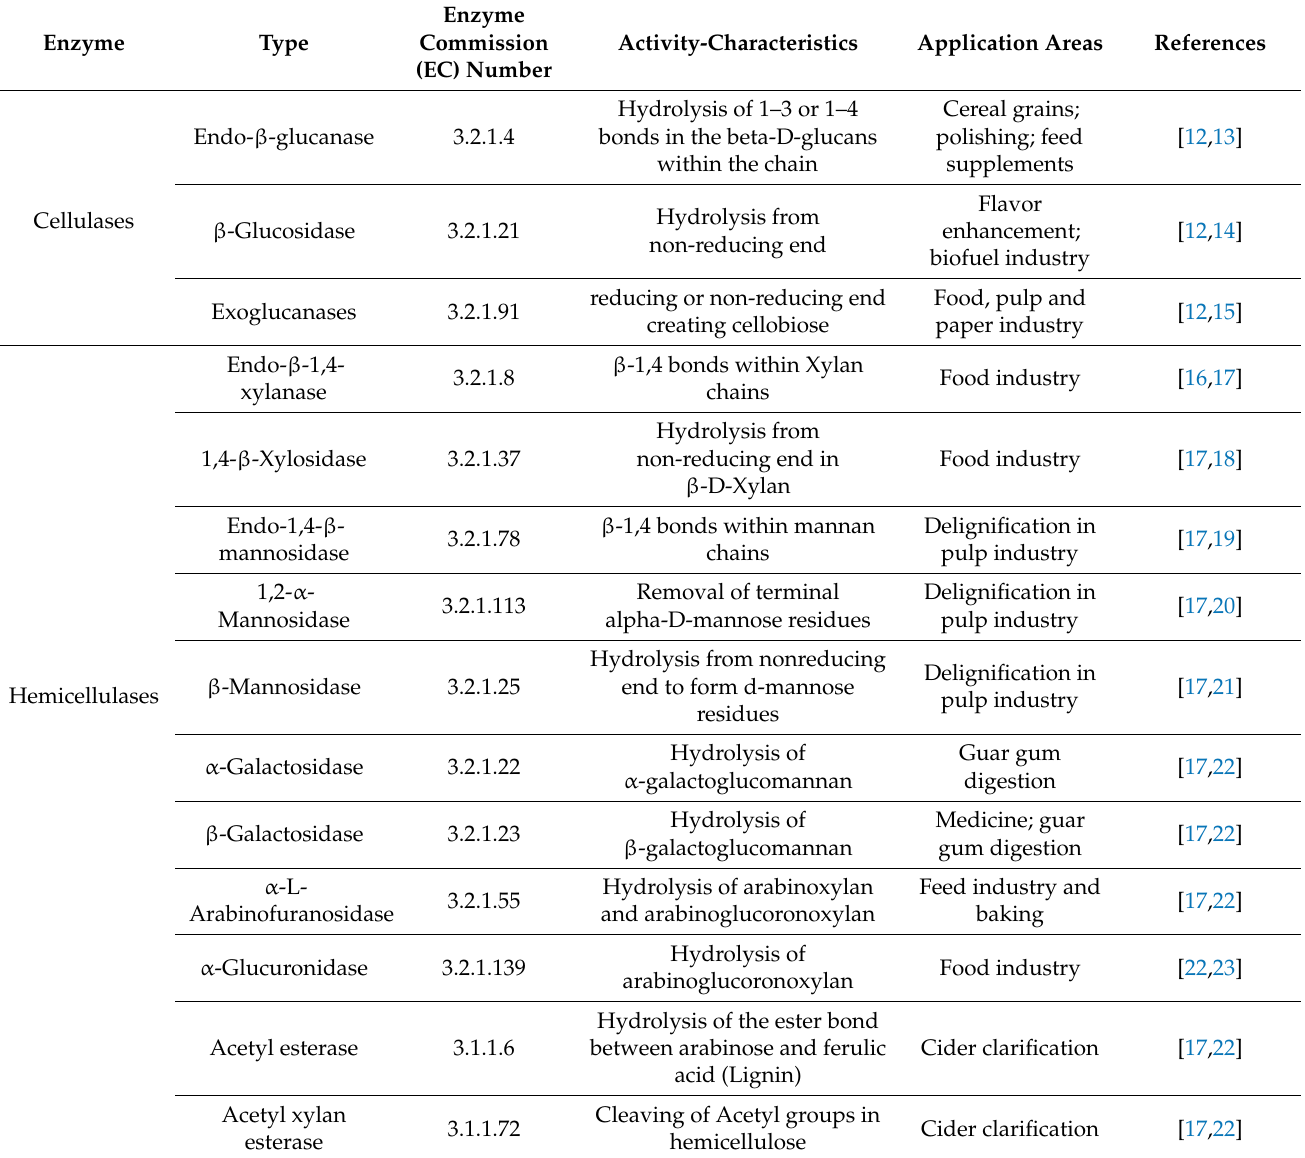
Table 1. Enzymes involved in the degradation of lignocellulosic biomass and their industrial applications.